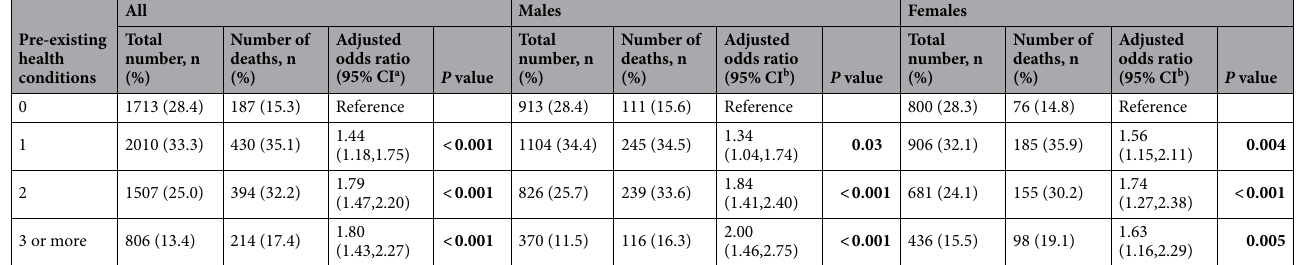
Table 3. Number of pre-existing health conditions and risk of COVID-19-related death. a Adjusted odds ratios: adjusted for age and sex. b Adjusted odds ratios: adjusted for age. CI Confidence Interval; COPD Chronic obstructive pulmonary disease. Significant values are in